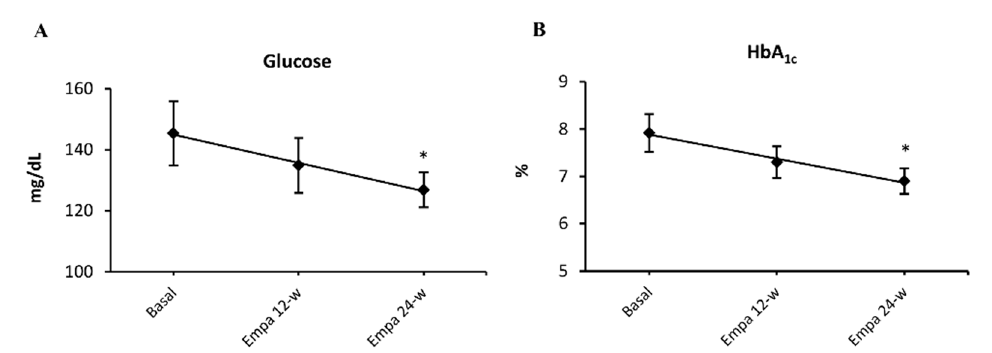
Figure 1. Empagliflozin effect on glucose metabolism. Blood glucose ( A ) and HbA1c levels ( B ) at 12 and at 24 weeks of treatment with empagliflozin 10 mg/day. Abbreviations: EMPA, empagliflozin; HbA1c %, glycated hemoglobin. * p < 0.05 vs. type 2 diabetes baseline.